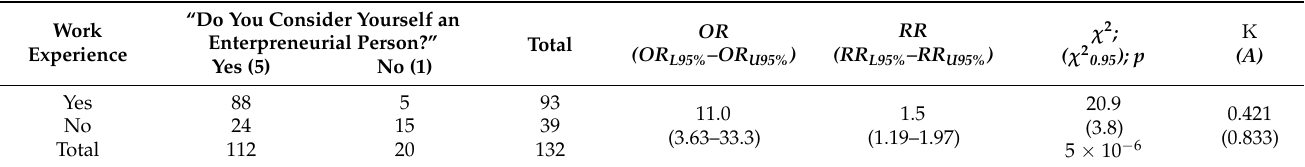
Table 2. Distribution of respondents’ answers to address the hypothesis that the presence of practical experience leads to higher confidence in students regarding their entrepreneurial abilities. Work